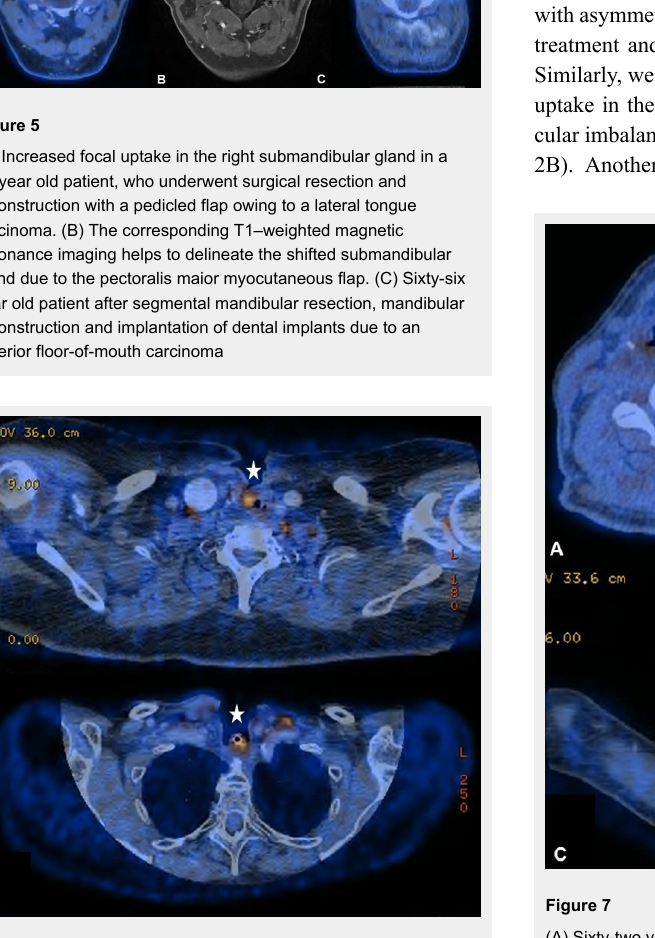
(A) Sixty-two year old patient after curative radio-chemotherapy (RCT) for a supraglottic larynx carcinoma with increased focal uptake in the left hypopharynx due to a radiogenic ulcer. (B) Increased focal uptake of the left mandible due to osteoradionecrosis in a 48-year old patient after curative RCT for an oropharynx carcinoma (C) Radiogenic chondronecrosis of the corniculate cartilages in a 59-year old patient after surgical resection and radiation therapy of a base of tongue